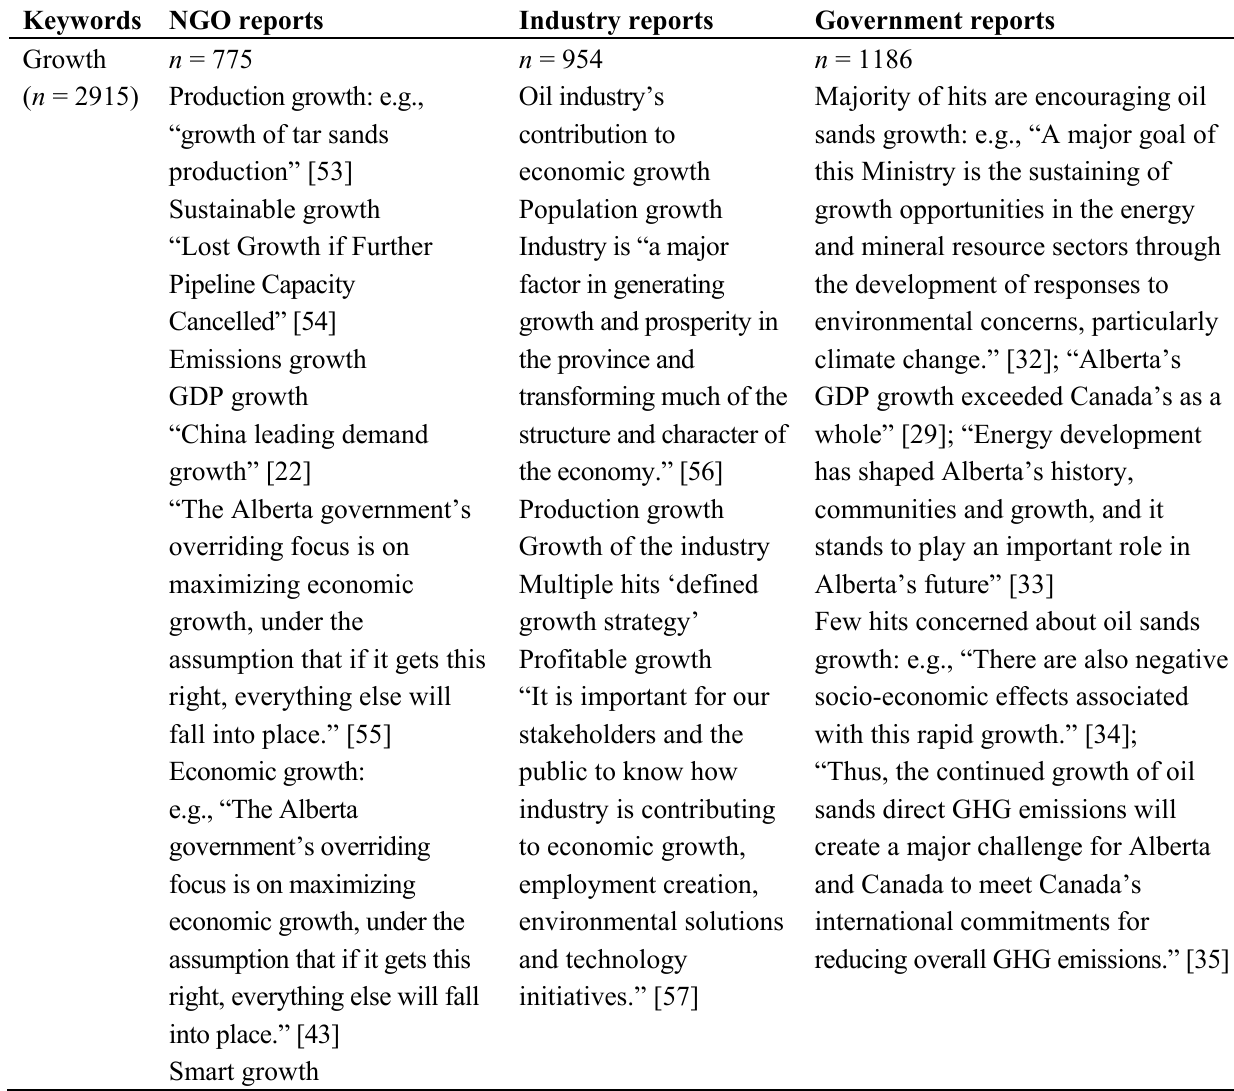
Table 8. Keyword “Growth” in all the